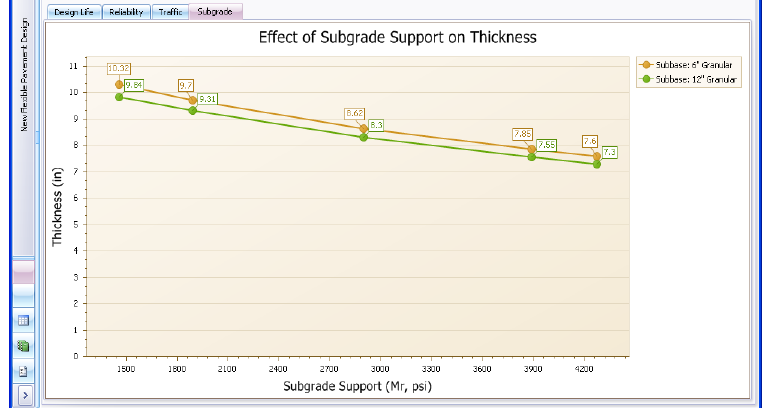
Figure 11. Screenshots of sensitivity analysis of subgrade strength on asphalt pavement thickness.